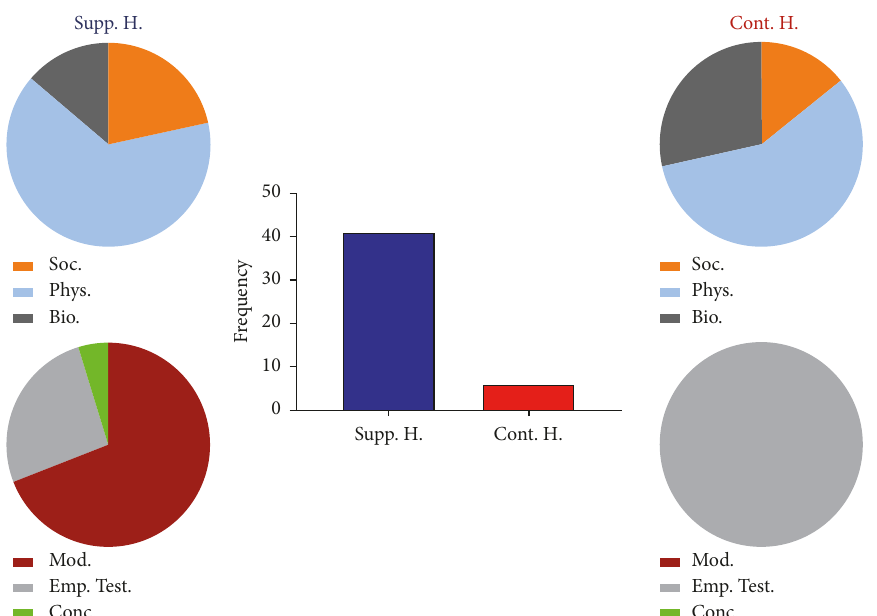
Figure 5: Visualising the frequency of quotes on the term herding that convey support for the theory versus those that challenge it. The pie charts on the left show the frequency of the supporting comments across the disciplines (on the top) and across the study types (in the bottom). Similarly, the pie charts on the right show the frequency of the contradicting comments again across the disciplines (on the top) and across the study types (in the bottom). The column chart in the middle compares the frequency of these comments in total regardless of the discipline or type of the study from which the comments were